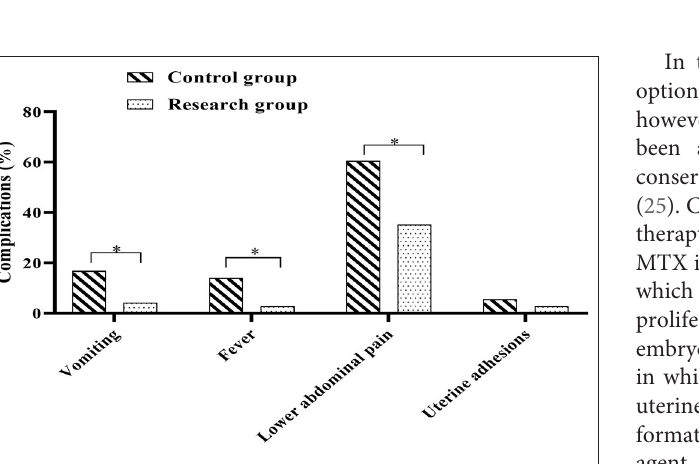
in order to preserve the patient’s reproductive function reduce the trauma caused by surgery to the patient and achieve better